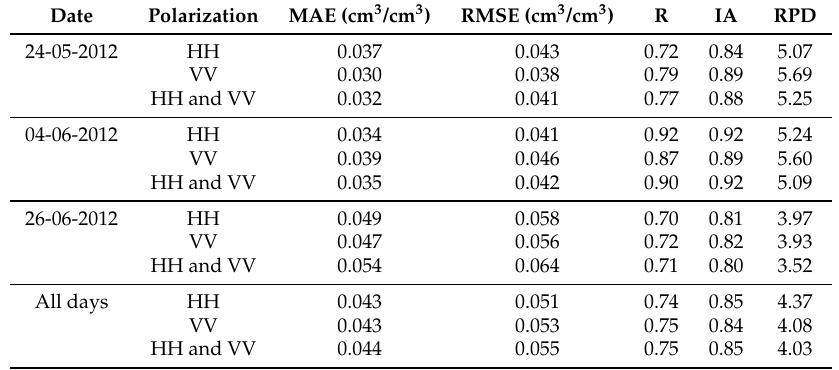
Table 7. Statistical evaluation parameters of SSM estimates of three inversion